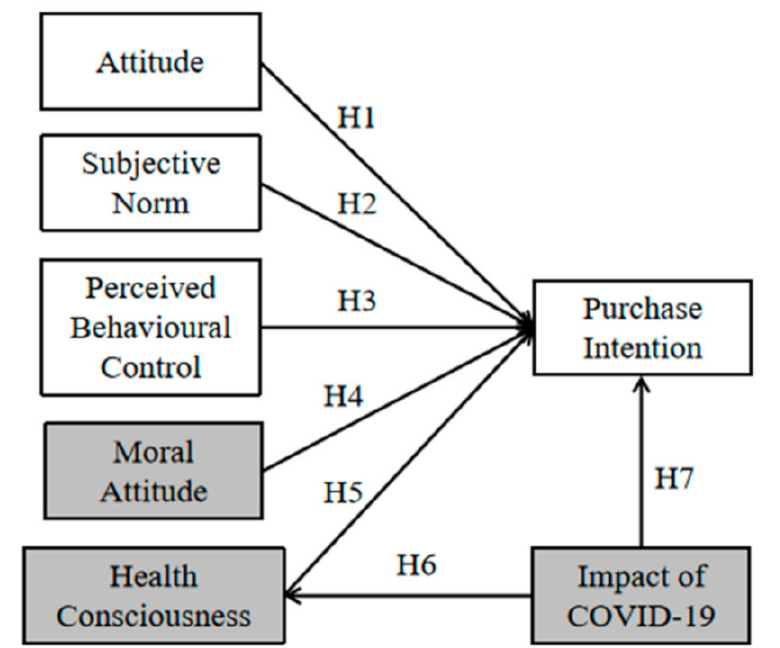
Figure 1. Research model: the white blocks are variables in the standard TPB model; the grey blocks and the white blocks are variables in the E-TPB model; H1, Hypothesis 1; H2, Hypothesis 2; H3, Hypothesis 3; H4, Hypothesis 4; H5, Hypothesis 5; H6, Hypothesis 6; H7, Hypothesis